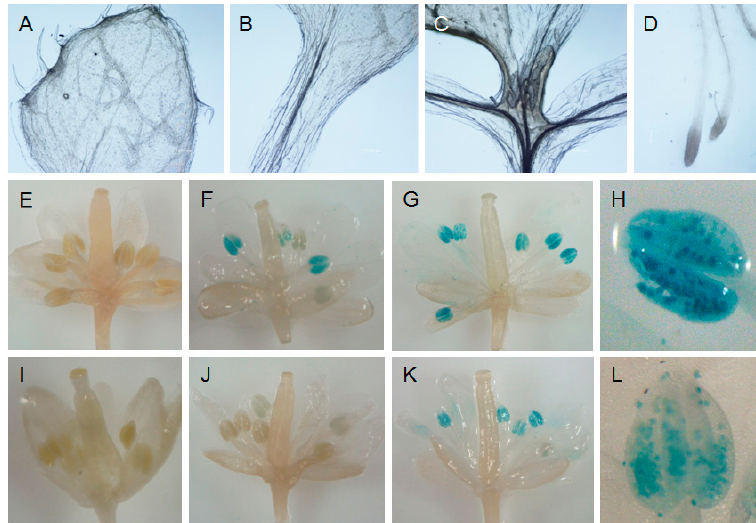
Figure 4. Expression pattern of functional ( A – H ) and disabled ( I – L ) alleles of AtTGG6 in Arabidopsis thaliana . Functional Prom::GUS and disabled Prom::GUS were transformed into Col-0, and stained with X-gluxuronide solution. ( A ) Rosette; ( B ) stem; ( C ) leaves; and ( D ) root of transgenic plant with functional Prom::GUS ; ( E ) a flower bud opened with a needle showing no GUS staining; ( F ) a flower one day before flowering opened with a needle showing the early expression; ( G ) a fully opened flower showing the high expression level; ( H ) an anther showing predominant expression in pollen; ( I ) a flower bud of disabled Prom::GUS opened with a needle showing no GUS staining; ( J ) a flower of disabled Prom::GUS one day before flowering showing weak expression; ( K ) a fully opened flower of disabled Prom::GUS showing expression at moderate level; ( L ) an anther showing disabled AtTGG6 predominantly transcribed in pollen.